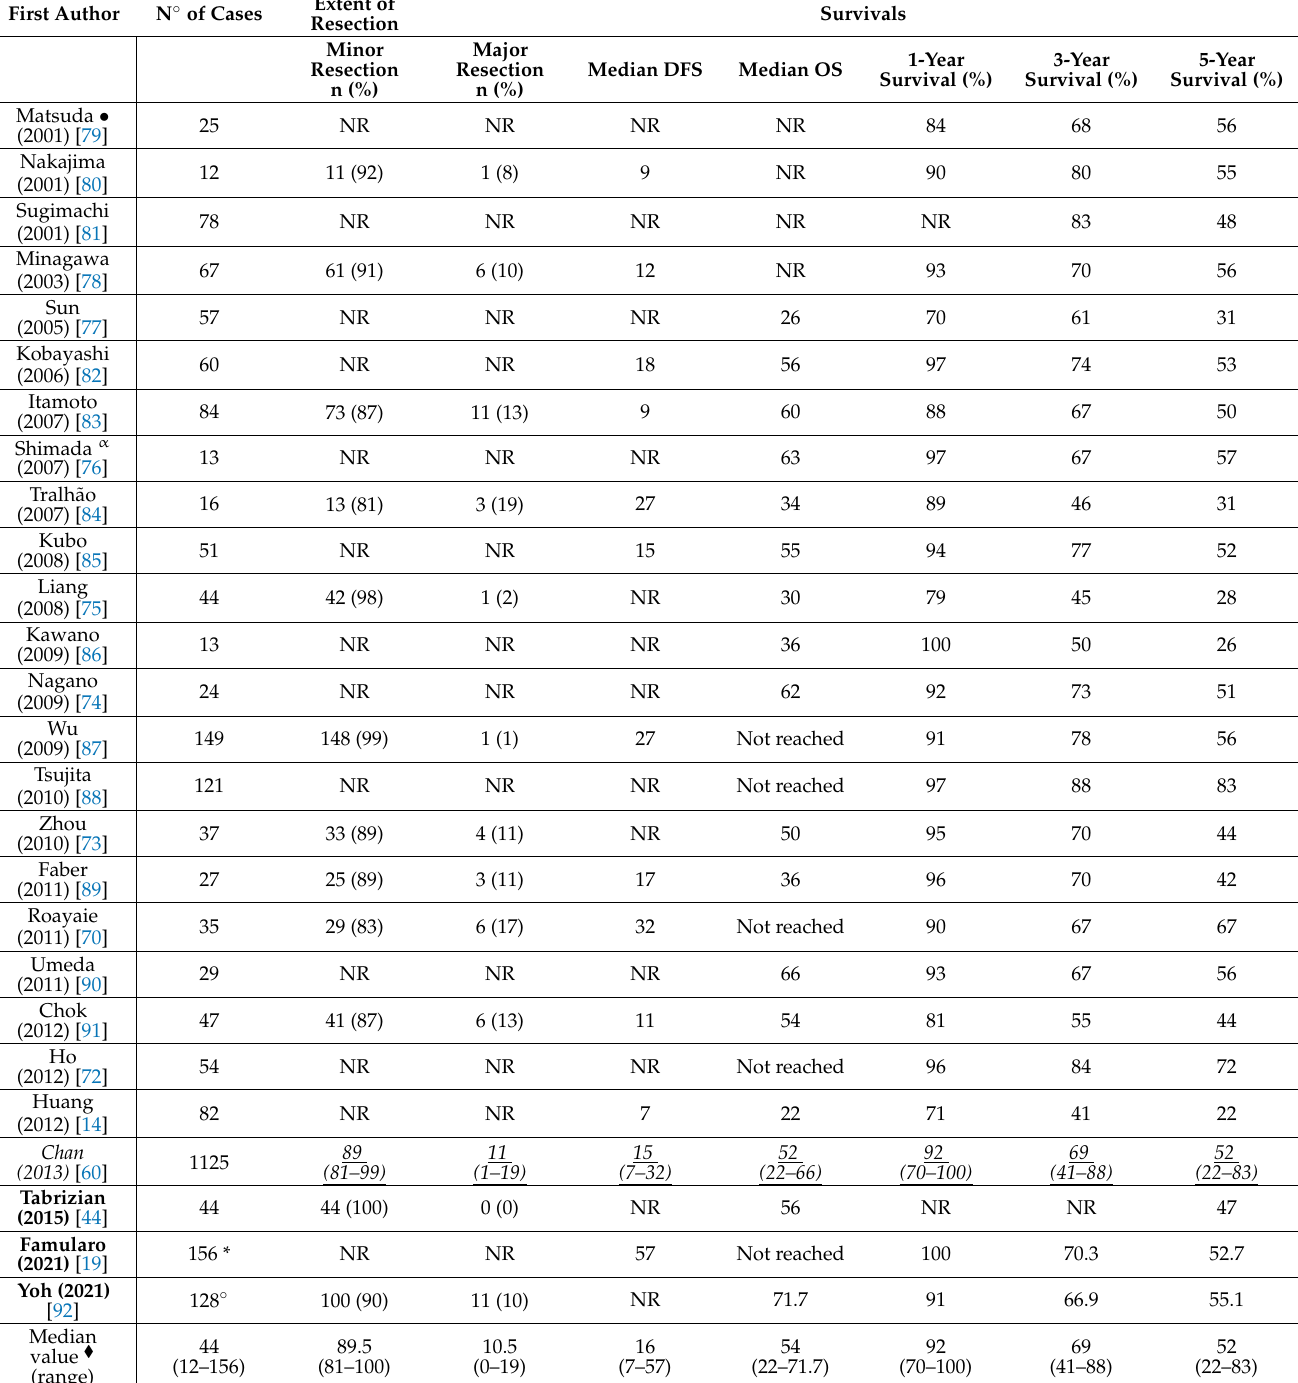
Table 1. Published papers on redo hepatectomy for recurrent hepatocellular carcinoma (after liver resection at first occurrence) in the last 20